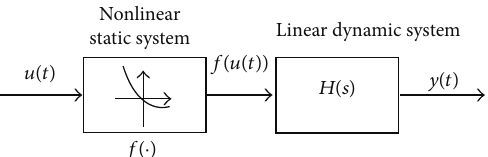
Figure 2: Nonlinear Hammerstein model. The model is defined with a static nonlinear block (the output does not depend on the derivative of the input) followed by a linear time invariant dynamic